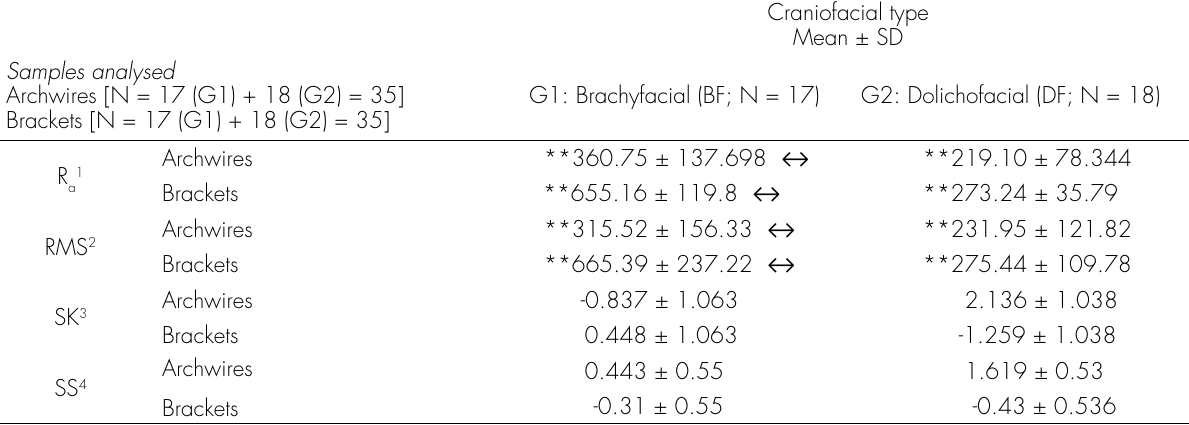
Table II. Surface roughness values of the orthodontic fixed appliances after canine sliding depending on the craniofacial type of the patients.